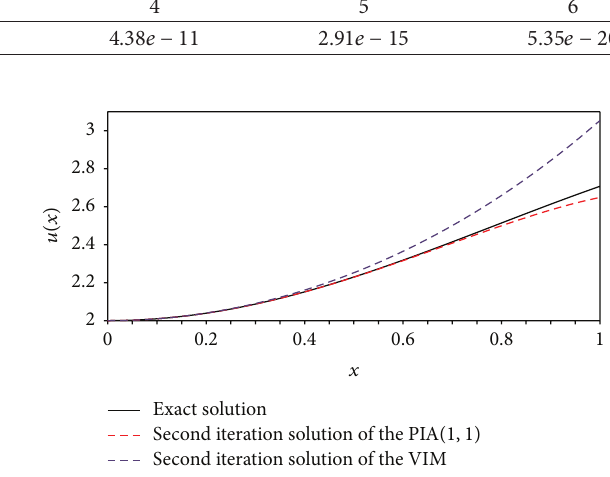
Figure 2: Comparison of the second iteration solutions of the VIM and PIA (1,1) with exact solution for example